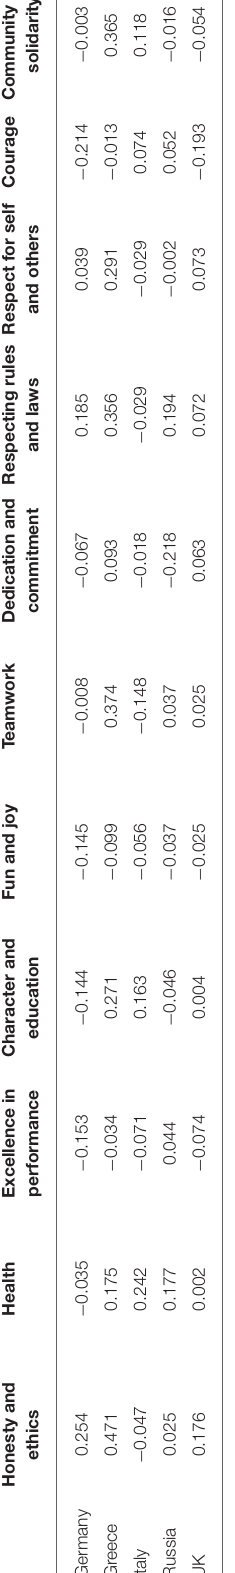
TABLE 6 | Significant differences between country correlations of importance of clean sport and spirit of sport